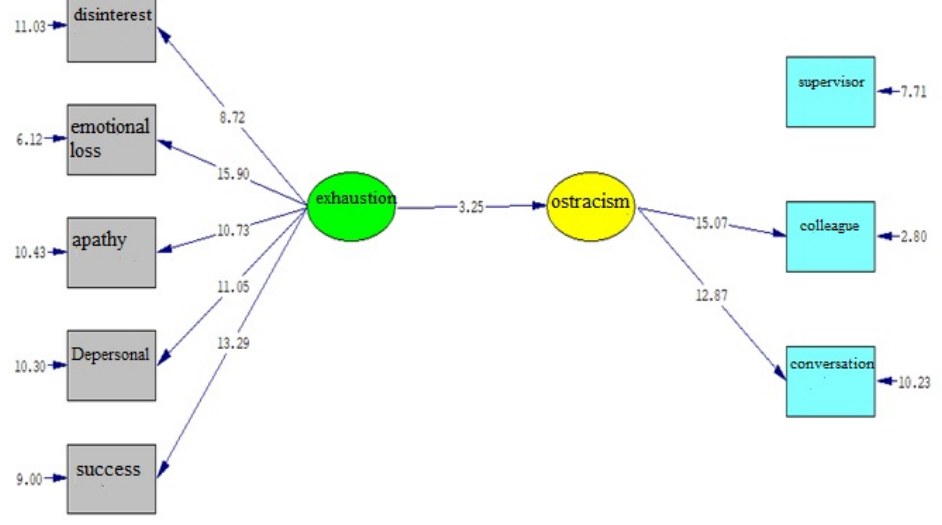
Figure 2. T-coefficient research model about role of emotional exhaustion on workplace